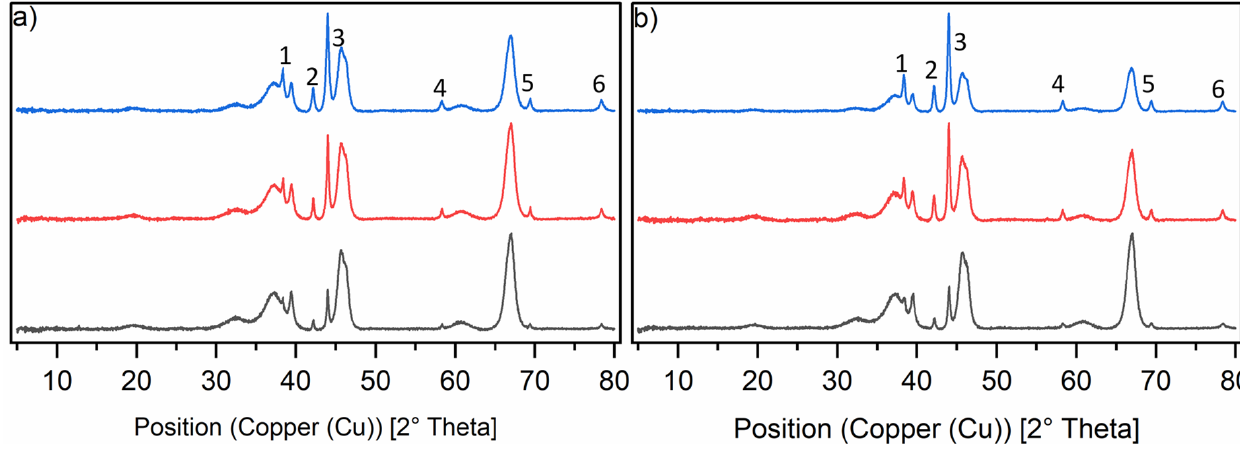
Figure 1. Normalised PXRD spectra of the six catalysts in the reduced state. Graph ( a ) shows the diffractograms of the Ru-NO-XX-icr. catalysts and Graph ( b ) shows the diffractograms of the Ru-Cl-XX-icr. catalysts. The black line shows the diffractograms of the Ru-XX-1 catalysts, the red line shows the diffractograms of the Ru-XX-3-icr. and the blue line shows the diffractograms of the Ru-XX-5-icr. catalysts. Ruthenium phases are marked in the diffractograms as follows: 1 = 100, 2 = 002, 3 = 101, 4 = 102, 5 = 110, 6 = 103.